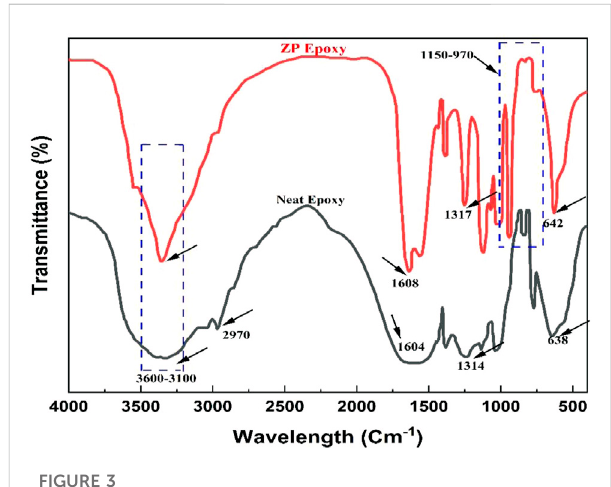
FIGURE 3 FT-IR of neat and modi fi ed epoxy coating